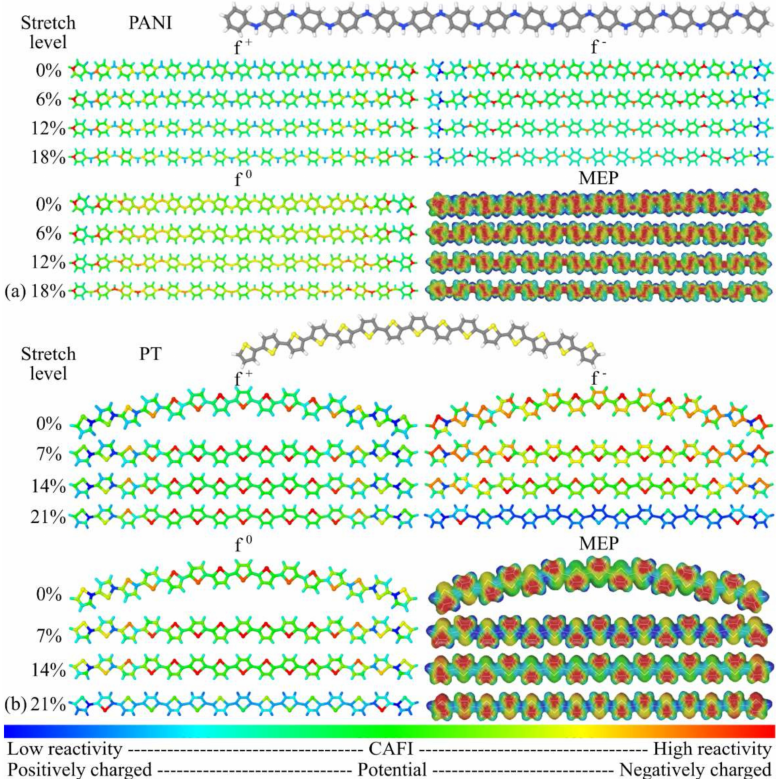
Figure 12. CAFI and MEP maps at distinct stretch levels: ( a ) PANI and ( b ) PT.